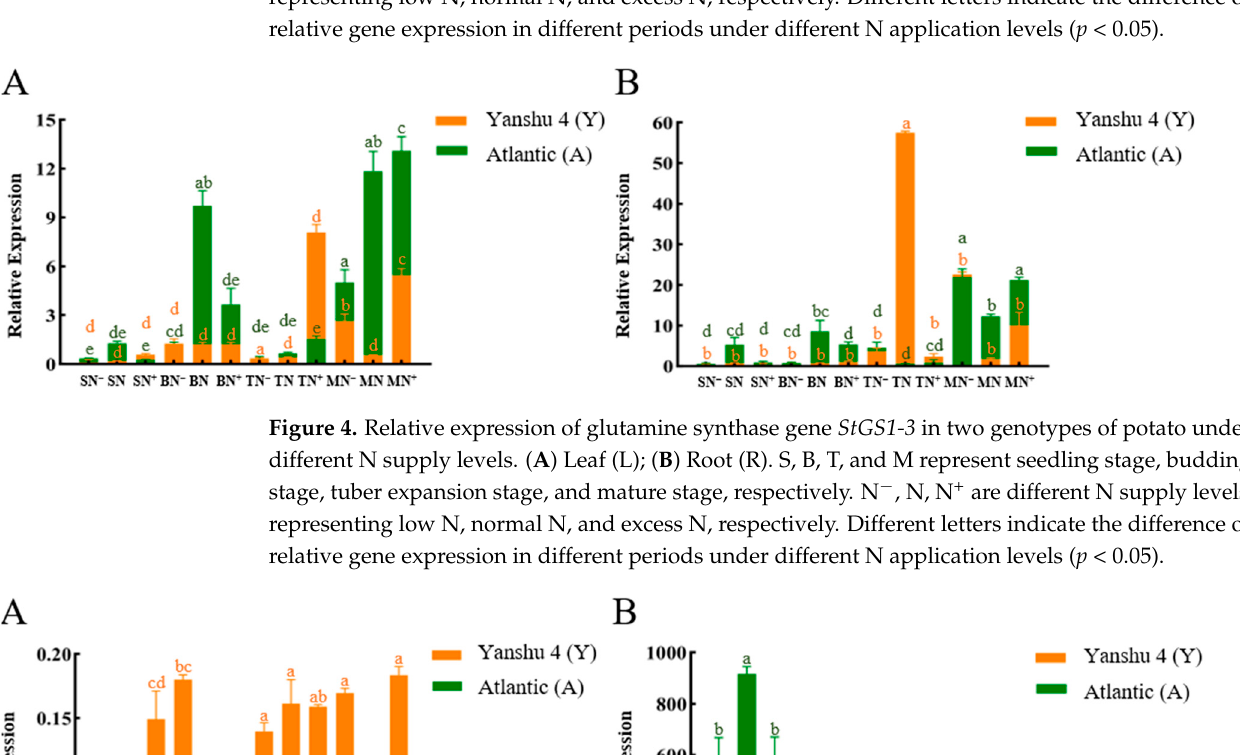
Figure 6. Relative expression of glutamine synthase gene StGS1-4 in two genotypes of potato under different N supply levels. ( A ) Leaf (L); ( B ) Root (R). S, B, T, and M represent seedling stage, budding stage, tuber expansion stage, and mature stage, respectively. N − , N, N + are different N supply levels, representing low N, normal N, and excess N, respectively. Different letters indicate the difference of relative gene expression in different periods under different N application levels ( p < 0.05). Figure 7. Relative expression of glutamine synthase gene StGS2 in two genotypes of potato under different N supply levels. ( A ) Leaf (L); ( B ) Root (R). S, B, T, and M represent seedling stage, budding stage, tuber expansion stage, and mature stage, respectively. N − , N, N + are different N supply levels, representing low N, normal N, and excess N, respectively. Different letters indicate the difference of relative gene expression in different periods under different N application levels ( p < 0.05).